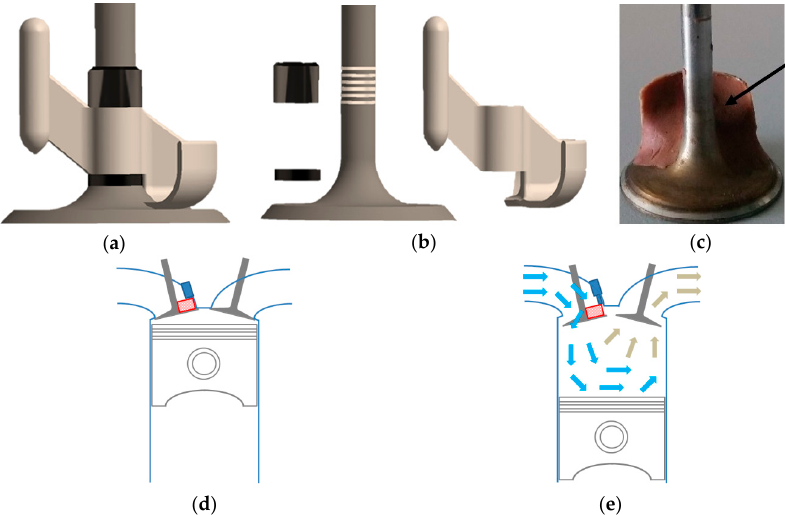
Figure 2. ( a , b ) schematic of the almost original inlet valve with an additional jockey. The complex shape of the jockey is vertically guided with, e.g., a radially pressed-on sleeve (black pieces). The jockey is held in a fixed angular position (guiding structure in the inlet channel not shown) and thus will not follow the valve´s rotation. The jockey redirects the fresh gas and a certain angle of the valve disk is almost completely obstructed. ( c ) Experimental inlet valve for flow visualizations with attached 120° jockey structure. ( d ) Arrangement in a nearly conventional 4-stroke engine design at TDC. ( e ) Schematic of scavenging near BDC; the flow-steering jockey is marked in red and the angular guiding structure in dark blue.